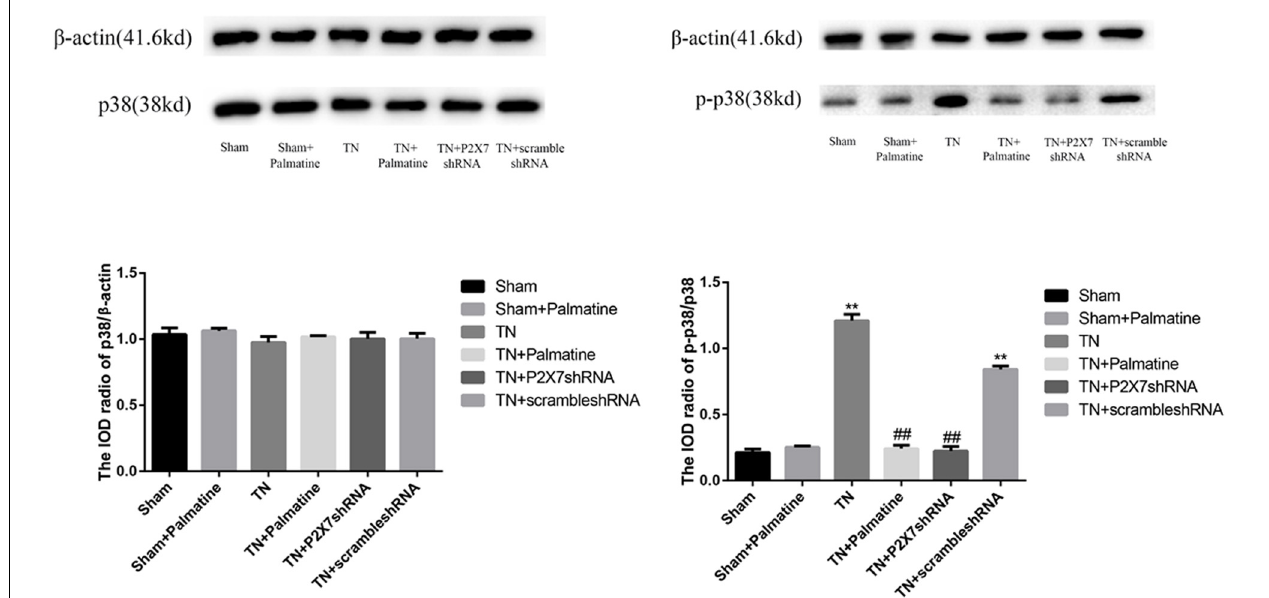
FIGURE 7 | Effects of palmatine on the phosphorylation of p38 in TGs detected by Western blotting. Using image analysis, the integrated OD values of P-p38 were normalized to p38/ β -actin. Values are mean ± SD, n = 6, ** p < 0.01 vs. sham group, ## p < 0.01 vs. TN group.